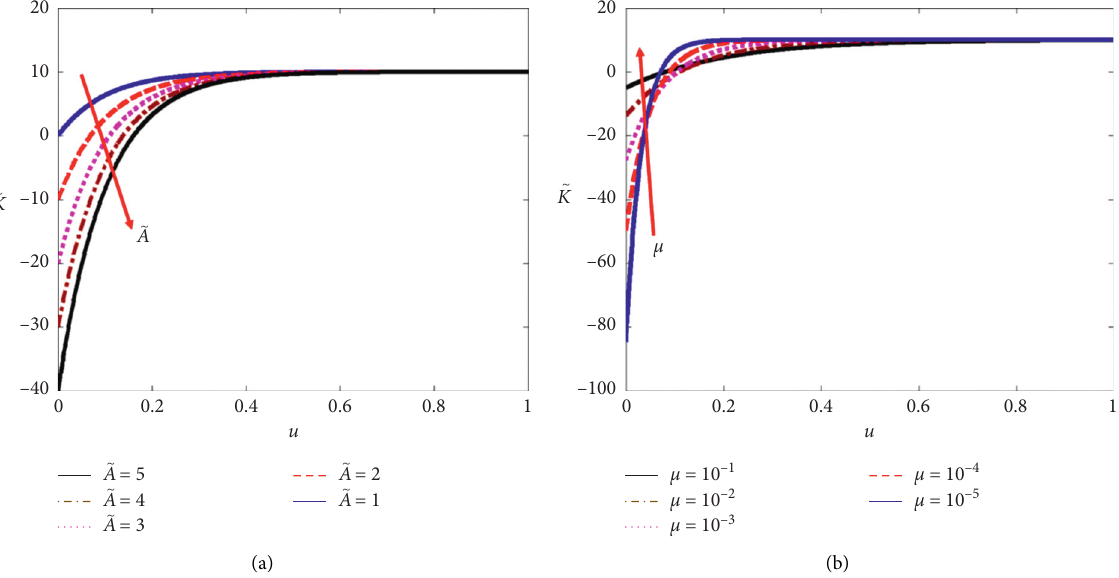
􏽥 A . k . (a) Different values of the parameter